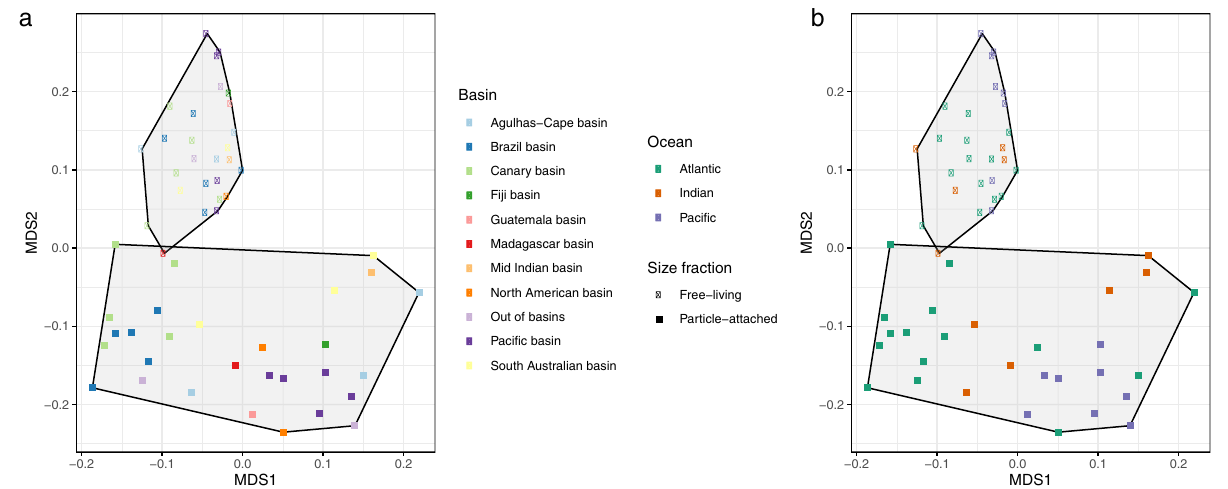
Fig. 2 Functional community structure of the bathypelagic microbial communities. Nonmetric multidimensional scaling (NMDS) of the microbial communities based on the functional compositional similarity (Bray – Curtis distances) among the 58 samples in the dataset, based on clusters of KEGG orthologous groups (KOs). a Size fraction is coded by the symbol (squares, particle-attached and circles, free-living prokaryotes) and b the main oceans and deep-oceanic basins by color codes (see legends).